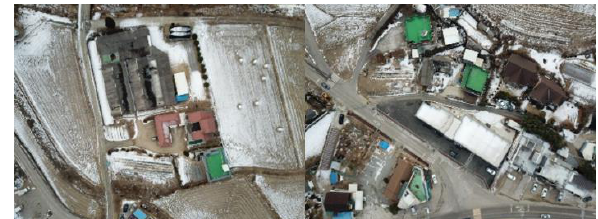
Figure 3. Examples of dataset A (acquired images)